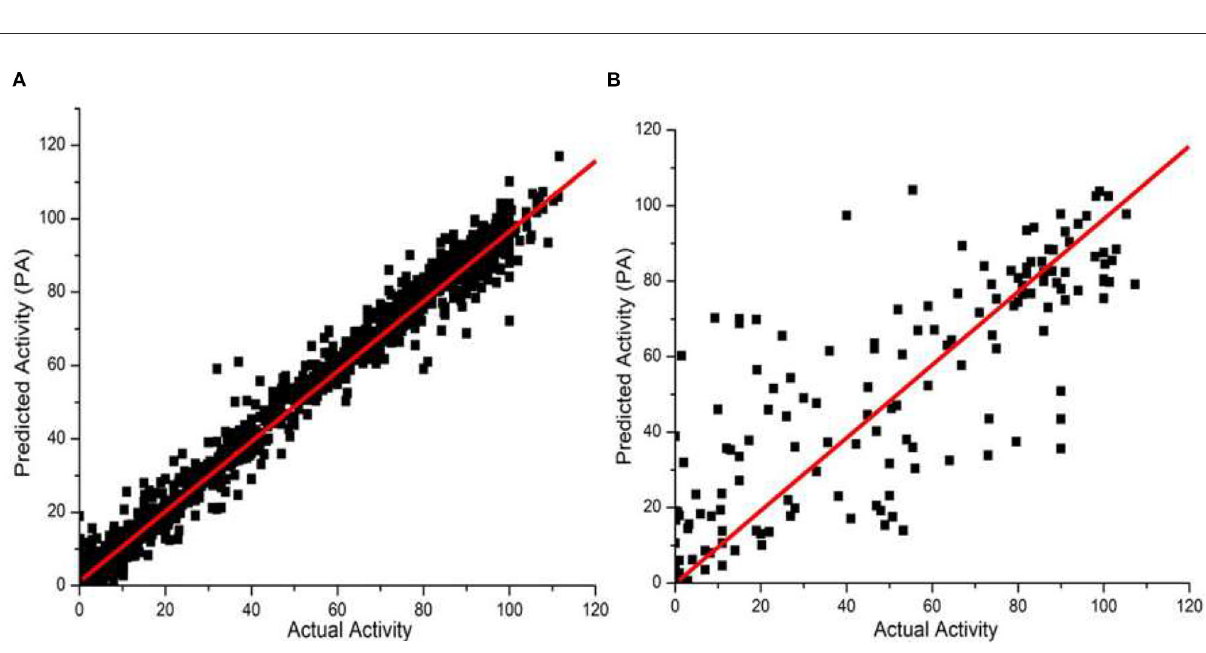
FIGURE5 Predicted vs. actual biological activities for the Merck Molecular Activity Challenge big data set in Kaggle competition. The model was built using 1,569 compounds with 4,505 descriptors. Among them 250 compounds are picked out randomly for test predictions, and the best model derived (A) q 2 = 0.99, shown in the left panel, and (B) r 2 = 0.65, shown in the right